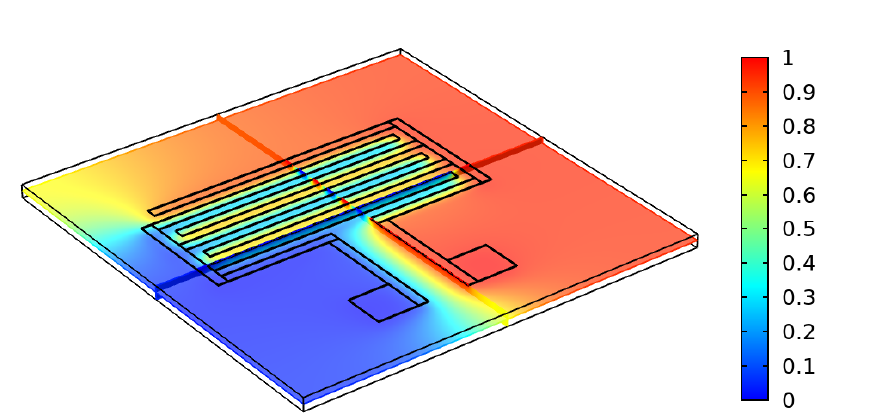
Figure 3. Electric distribution (V) in 3D mode for the rectangular